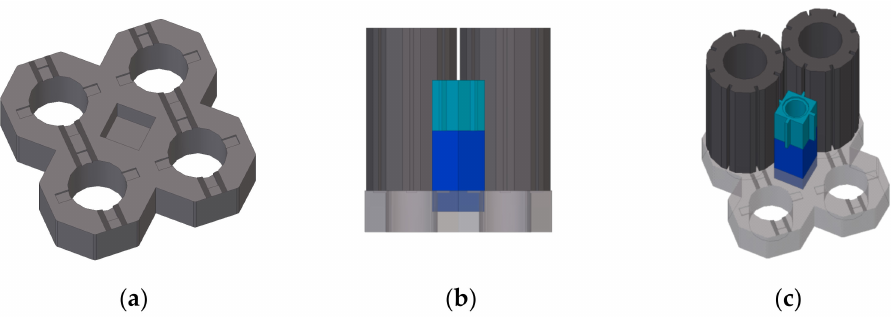
Figure 1. ( a ) Detail of the base plate. ( b ) Installation of fuel and interstitial bricks on the base plate, side view. ( c ) Installation of fuel and interstitial bricks on the base plate, isometric